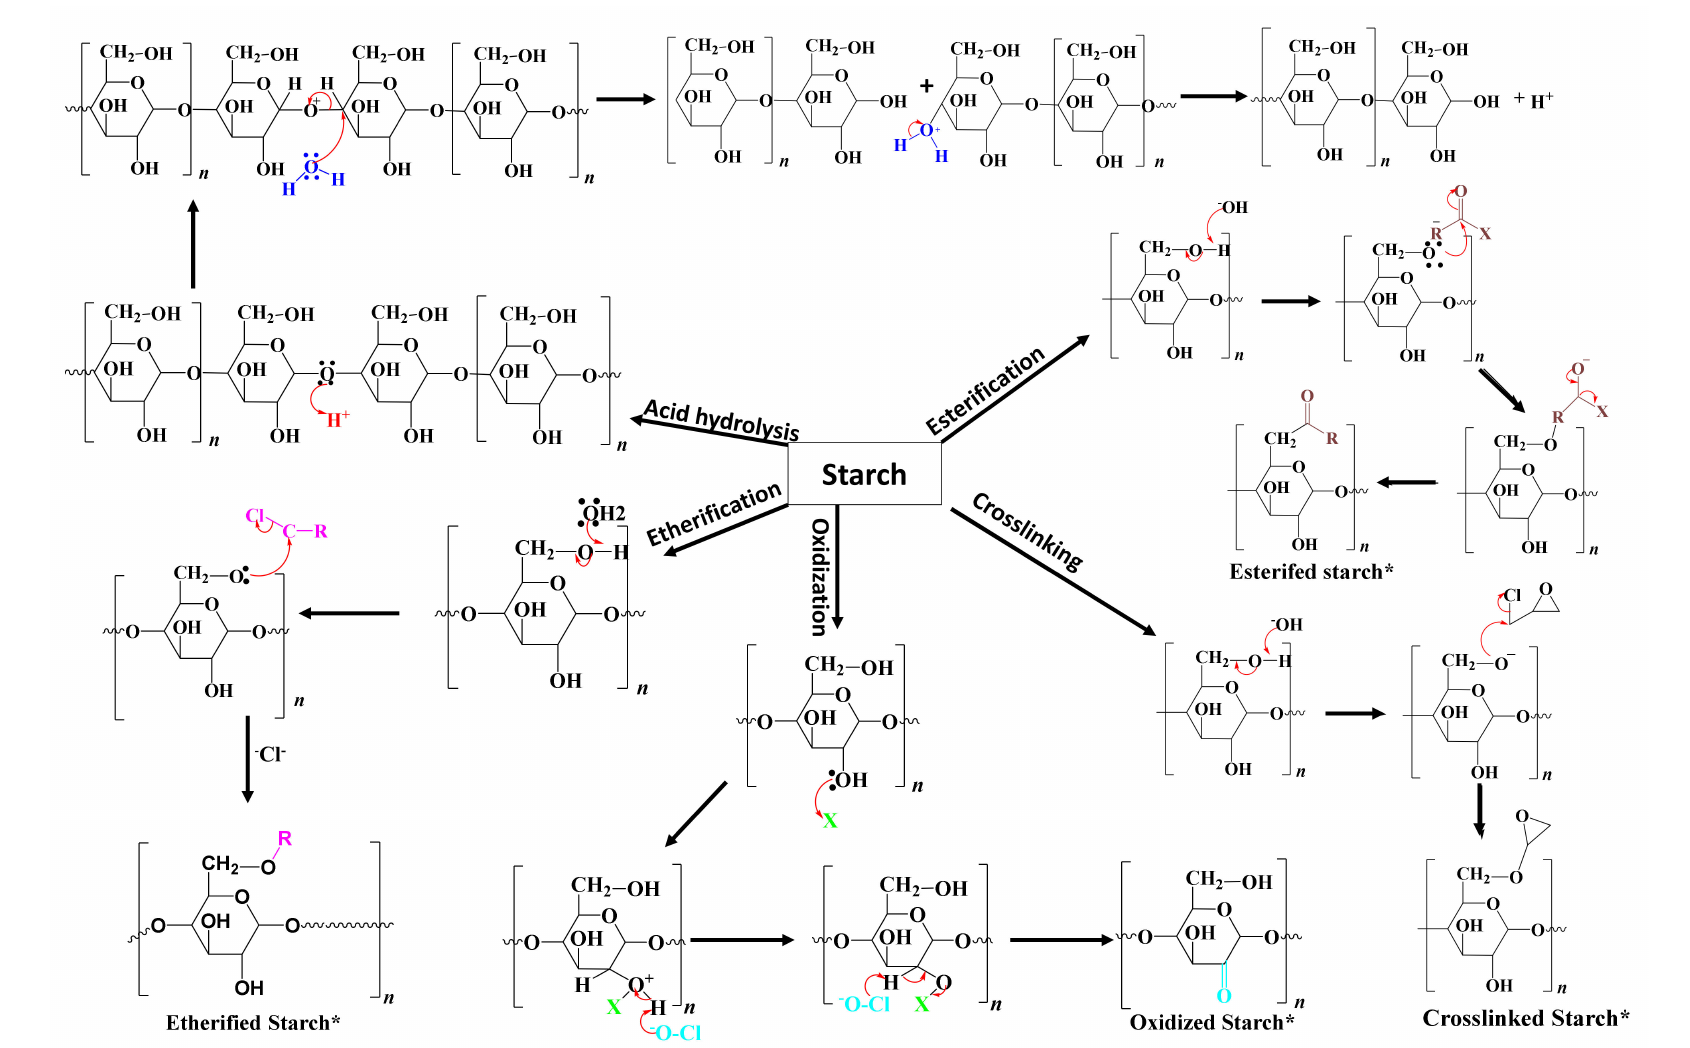
Figure 5. The reaction mechanisms of different chemical modification